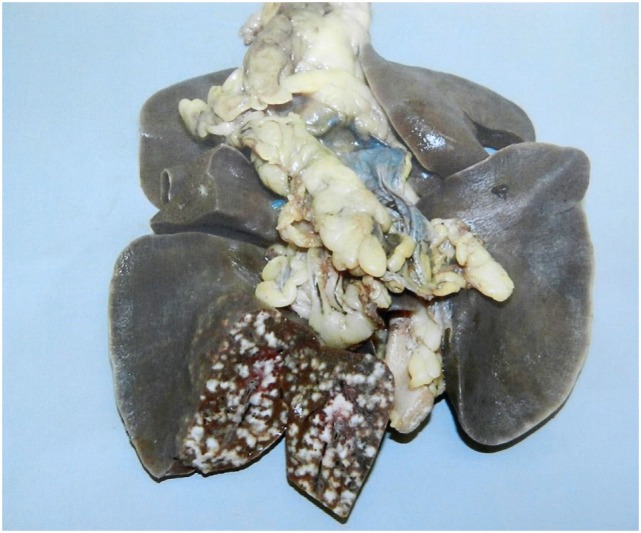
Experimental infection. Lesions of experimental pulmonary tuberculosis with miliary lesions of a uniform size in the inoculated lobe. In natural-infected badgers typically fewer pulmonary lesions are observed and they vary in size.